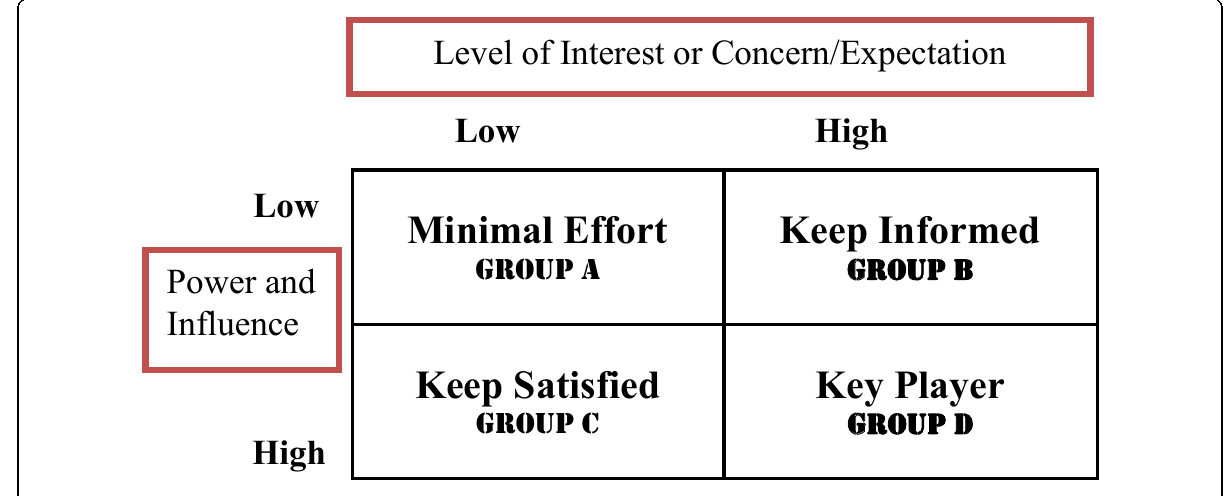
Figure 1 Critical stakeholder mapping for the college